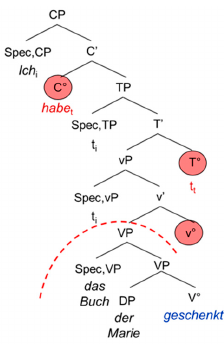
Figure 3. Structure of the German main clause.